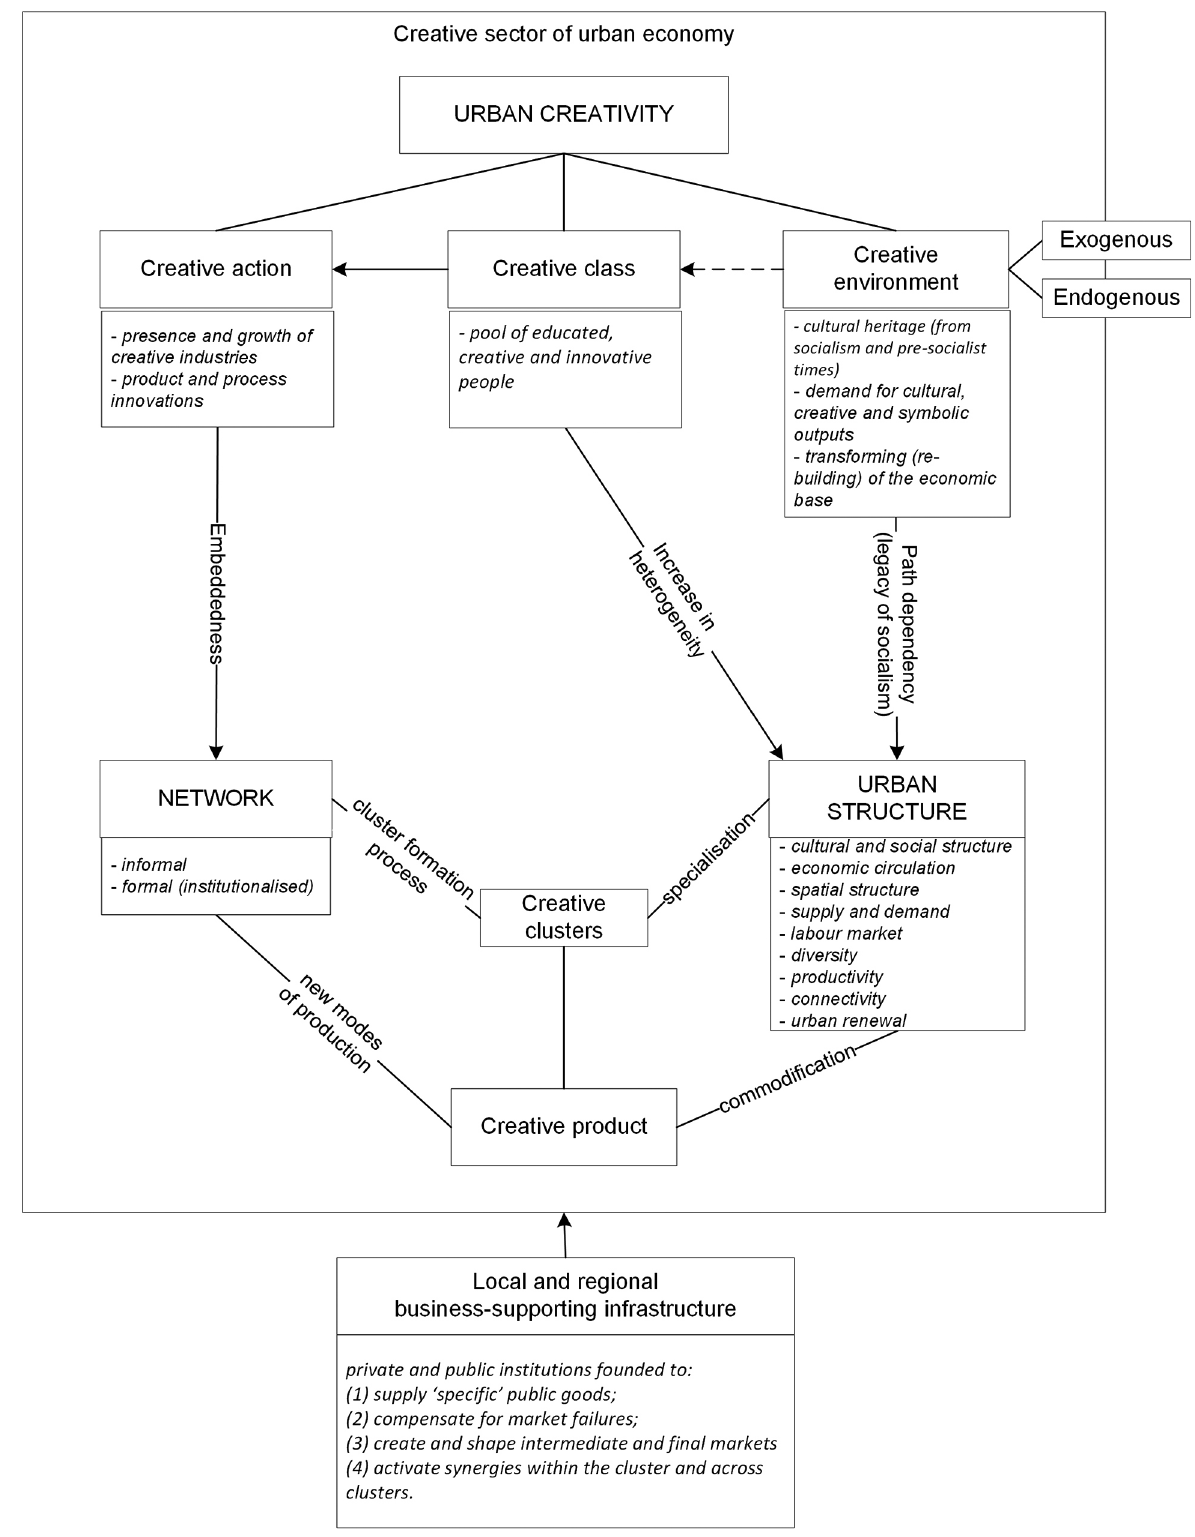
Fig. 2. Urban creativity in the post-socialist city Source: own